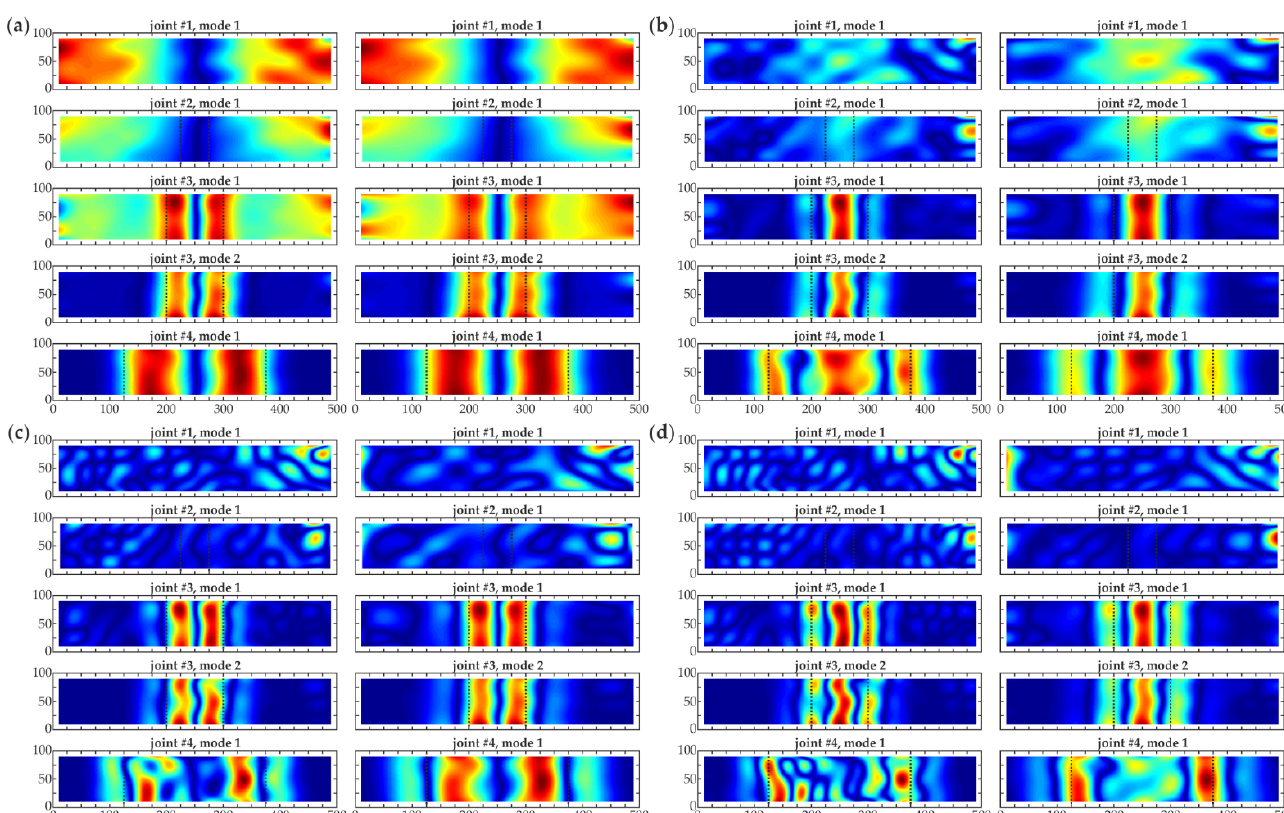
Figure 10. CWT damage imaging for experimental results (grid 20 mm interpolated to 2 mm) for all joints #1–#4 (dimensions in [mm]) using different wavelets for scales s = 16 (left column) and s = 24 (right column): ( a ) gaus1 ; ( b ) gaus2 ; ( c ) gaus3 ; ( d ) gaus4 .